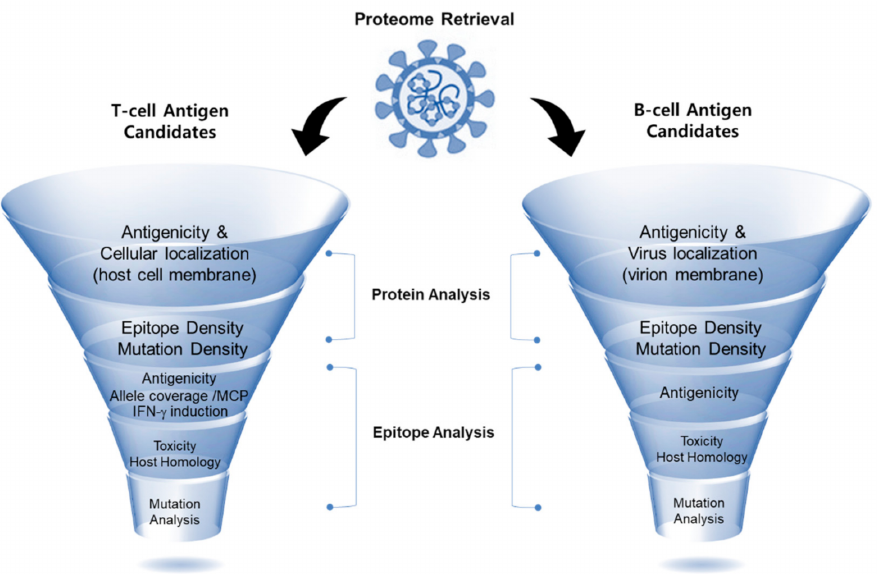
Figure 1. Illustration of our workflow of reverse vaccinology applied for the in silico screening of immunogenic SARS-CoV-2 viral epitopes. First, data retrieval of the selected pathogen (SARS-CoV-2) was carried out, which was followed by protein analysis through the determination of three aspects (cellular localization, antigenicity, and epitope density). Subsequently, the identified B-cell and T-cell epitopes were analyzed based on their predicted antigenicity, allele coverage, and IFN- γ induction (for T-cell epitopes). Next, epitopes were further checked for their toxicity and host homology. Finally, mutation analysis was conducted to determine the conservation of the selected